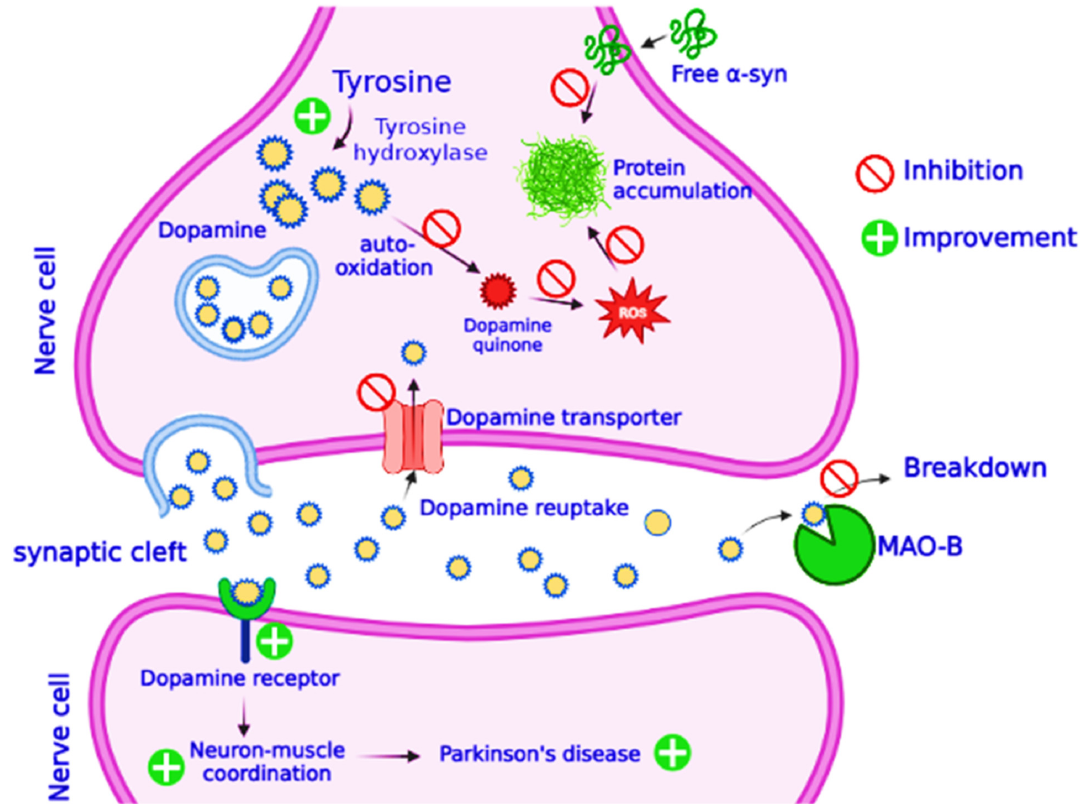
Figure 5. Role of green tea catechins in prevention of Parkinson’s disease. The protective mechanism of catechins has been elaborated. Parkinson’s disease is characterized by dopamine deficiency, and all treatment measures are aimed at introduction of dopamine as a medicine and its preservation. The figure illustrates conversion of tyrosine to dopamine by the action of an enzyme tyrosine hydroxylase; newly synthesized dopamine is packed into vesicles and released into the synaptic cleft, where it binds with the dopamine-specific receptors and contributes its role in signaling between two nerve cells. Normally, dopamine is reabsorbed to the nerve cells and reused, or it is broken down by the action of an enzyme monoamine oxidase B (MAO-B). Presence of green tea catechins inhibits MAO-B activity and promotes dopamine reabsorption. Catechins also inhibit plaque formation by the proteins and autoxidation of